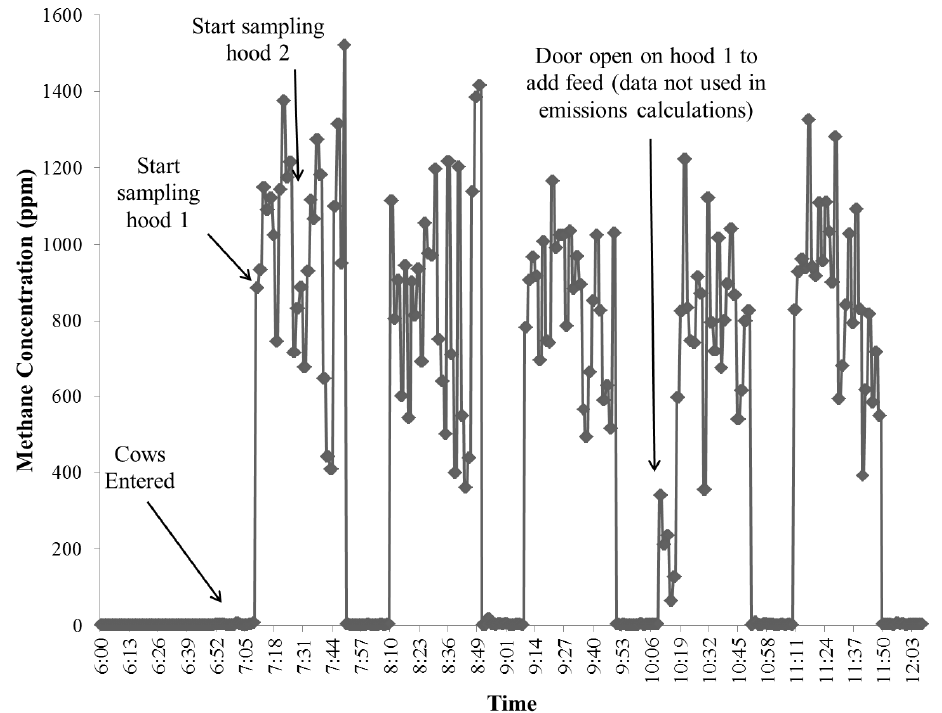
Figure 10. Example of raw methane concentrations (ppm) over time from the TEI-55C.